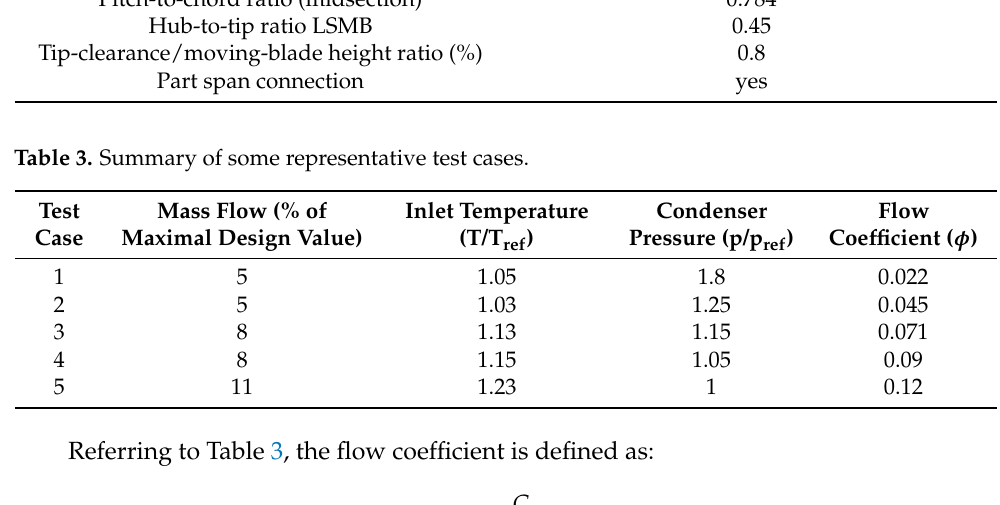
Table 3. Summary of some representative test cases.